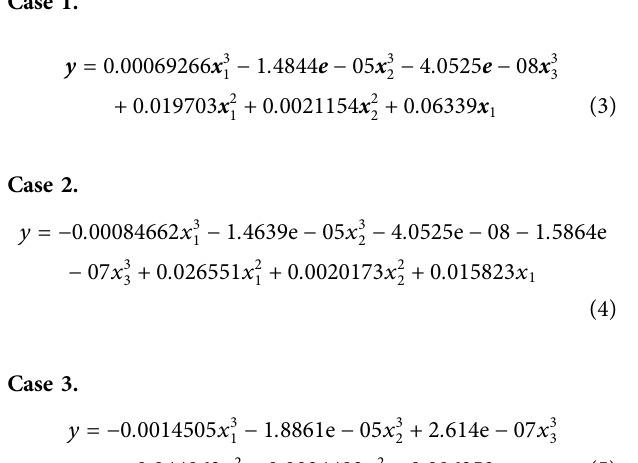
Frontiers in Bioengineering and Biotechnology |